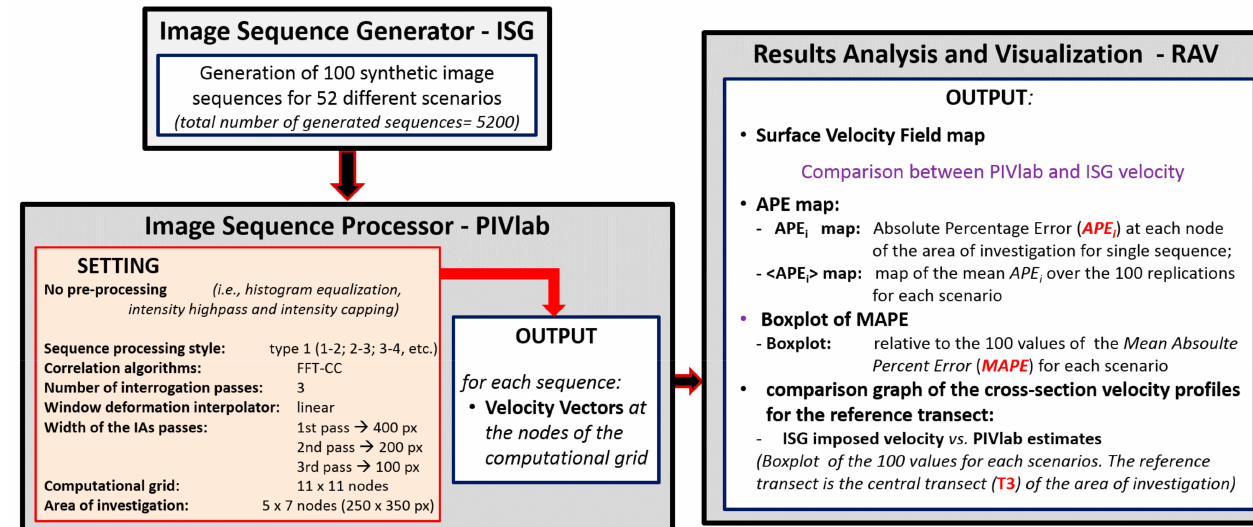
Figure 1. Schematic representation of the modeling chain implemented in MATLAB, including the following modules: (i) Image Sequence Generator (ISG); (ii) Image Sequence Processor (PIVlab); (iii) Results Analysis and Visualization (RAV). Settings and output of each module are